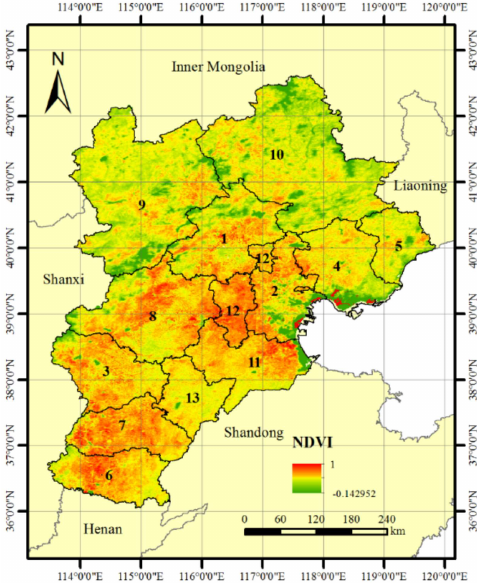
Figure 1.Location of the Beijing-Tianjin-Hebei region